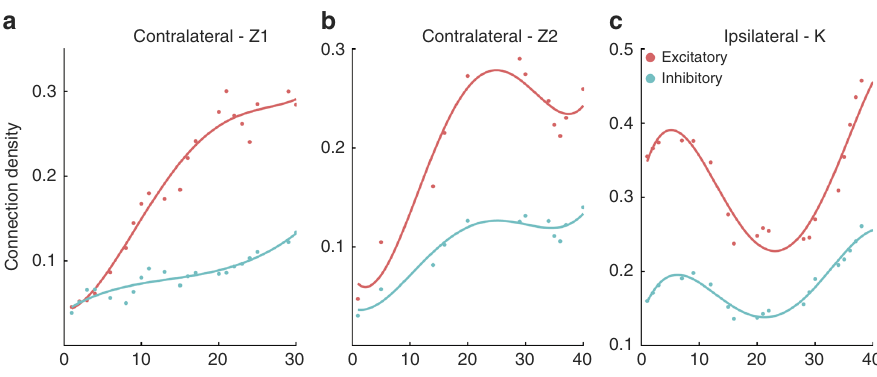
Fig. 3 Network connection density among excitatory and inhibitory connections. a , b correspond to the two experiments with the contralateral monkey Z and c shows the network density in the ipsilateral monkey K. (solid lines are fourth order polynomial fi ts to the data